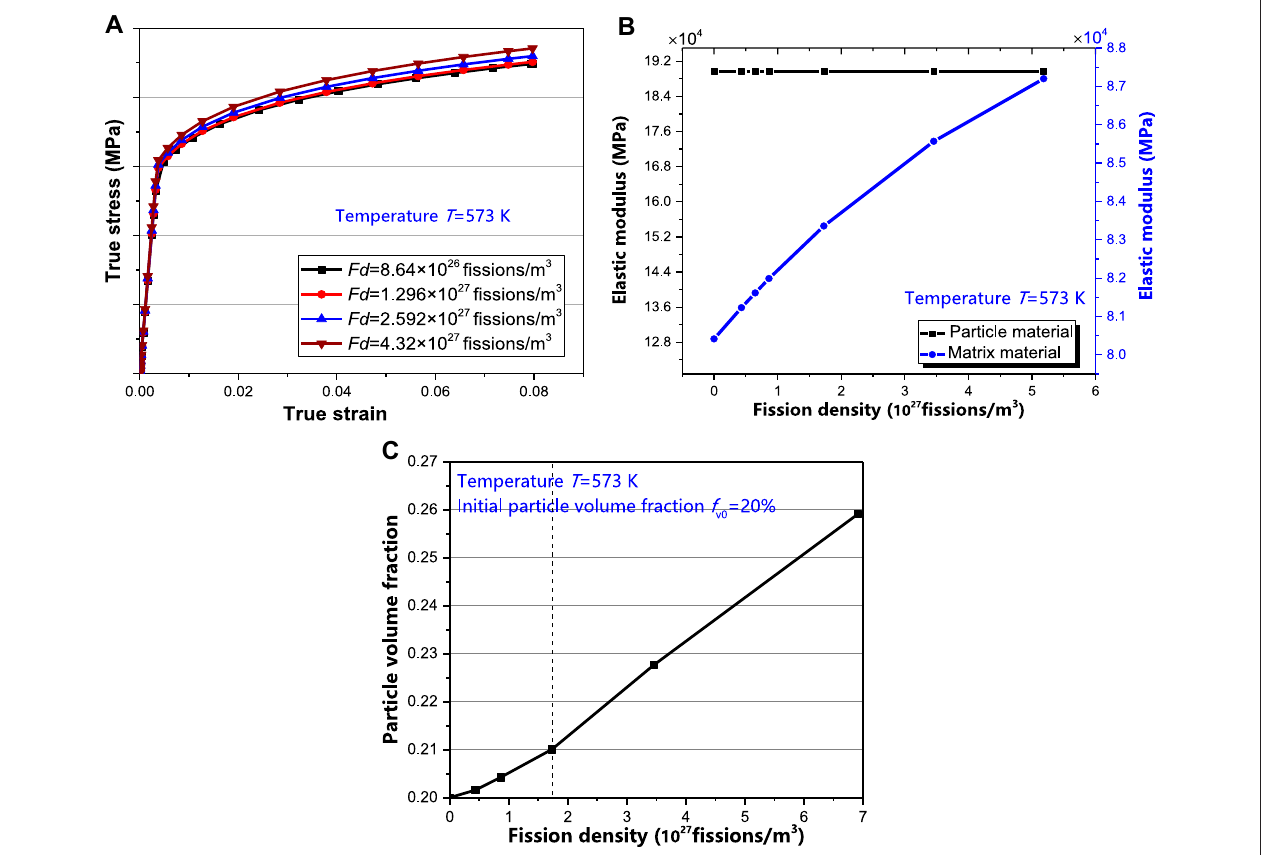
FIGURE9|(A) Truestress – straincurvesofthemetalmatrixmaterial, (B) theelasticmodulusoftheparticlematerialandmatrixmaterial,and (C) theparticlevolume fraction after different fi ssion densities.